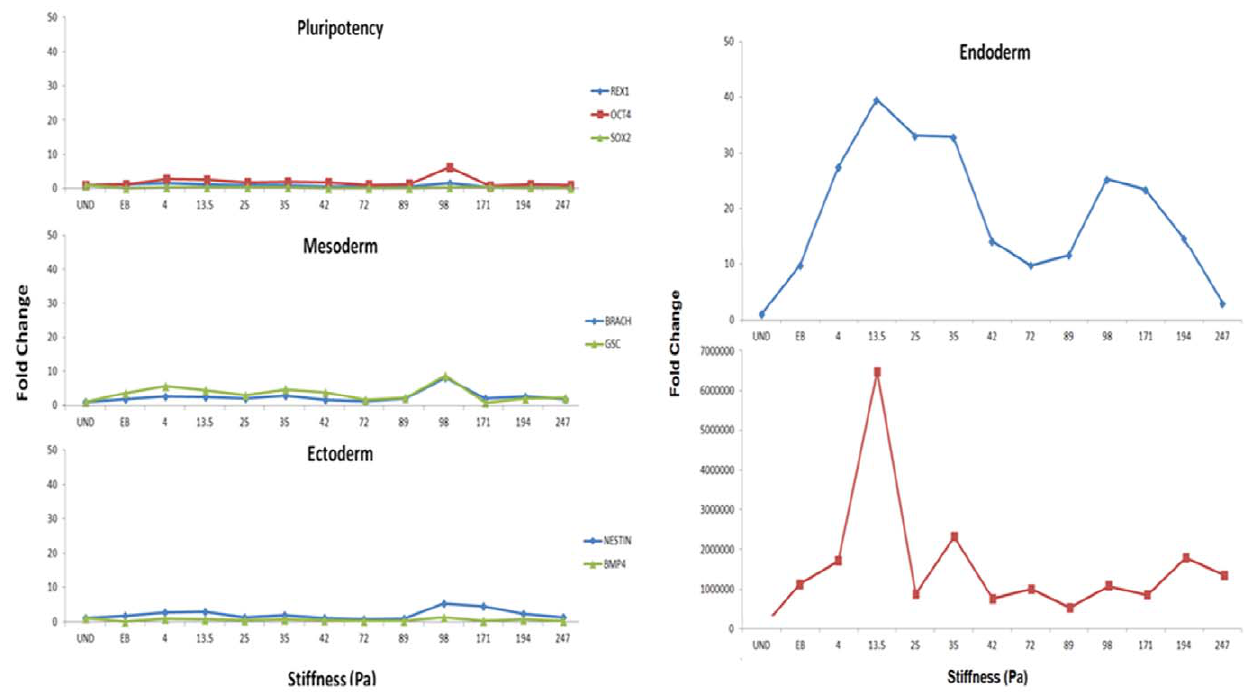
Figure 1. Effect of stiffness of fibrin substrate on early differentiation patterning of mouse embryonic stem cell. Embryonic stem cells were differentiated for 4 days on fibrin substrates of varying properties. Analysis of the differentiated cells for pluripotency and germ layer markers at the end of differentiation reveals that pluripotency, mesoderm and ectoderm markers are relatively insensitive to changes in substrate stiffness. The endoderm markers, specifically Sox17 and AFP responded strongly to the changes in stiffness in the chosen range. A lower value of stiffness resulted in stronger up-regulation of endoderm marker. The above analysis is for 3D culture configuration. In order to evaluate the effect of the substrate relative to chemical induction, a control experiment of spontaneous differentiation by embryoid body formation was performed, depicted by EB in the above plots. Spontaneous differentiation by EB formation typically resulted in lower upregulation compared to induction by fibrin substrate. doi:10.1371/journal.pone.0035700.g001 further shows that number of genes is more sensitive to W r than the increase in number of genes is more dominant the overall number of conditions. Increasing row weight increases the number effect is an increase in volume with W r . An opposite trend is observed for W c , where increase in W c increases the number of of genes while reducing the number of conditions however, since